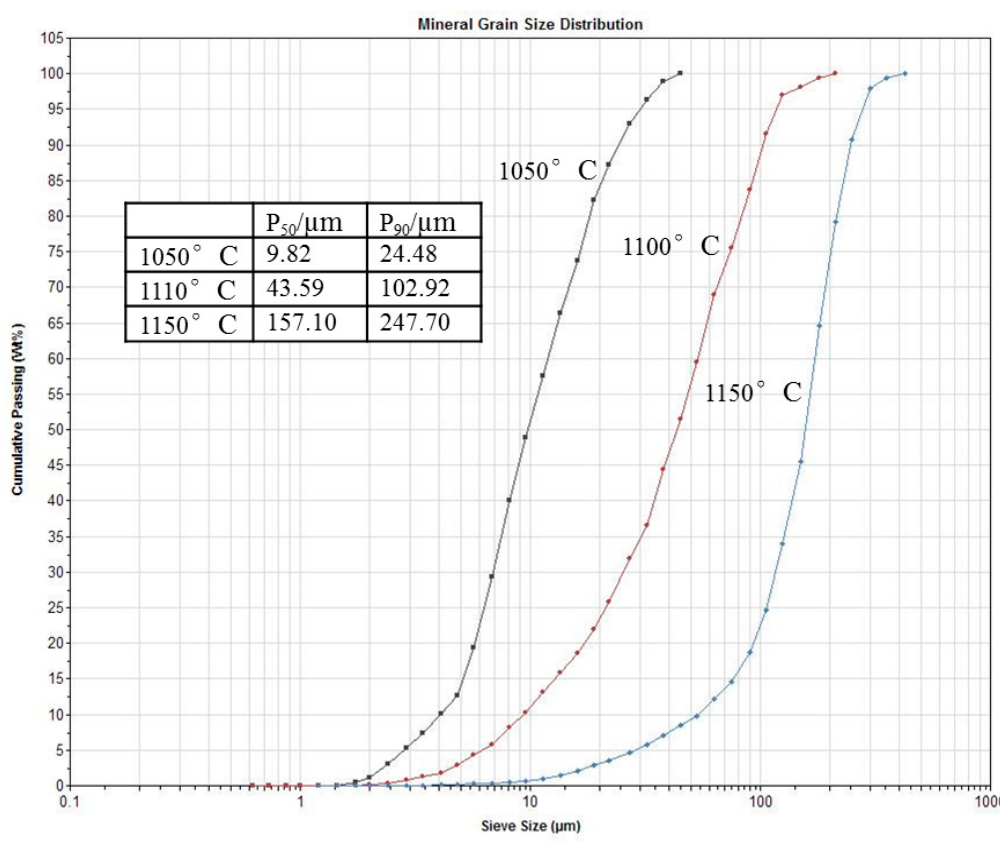
Figure 14. Alloy particles size distribution of the calcines at 1050 °C, 1100 °C, and 1150 °C.